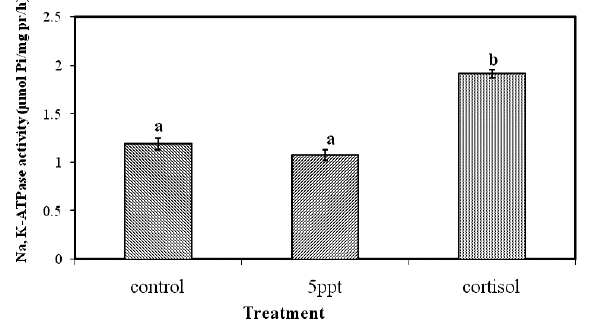
penser persicus fry. Values are means± SE. Different letter above the columns indicate significant difference between treatments.